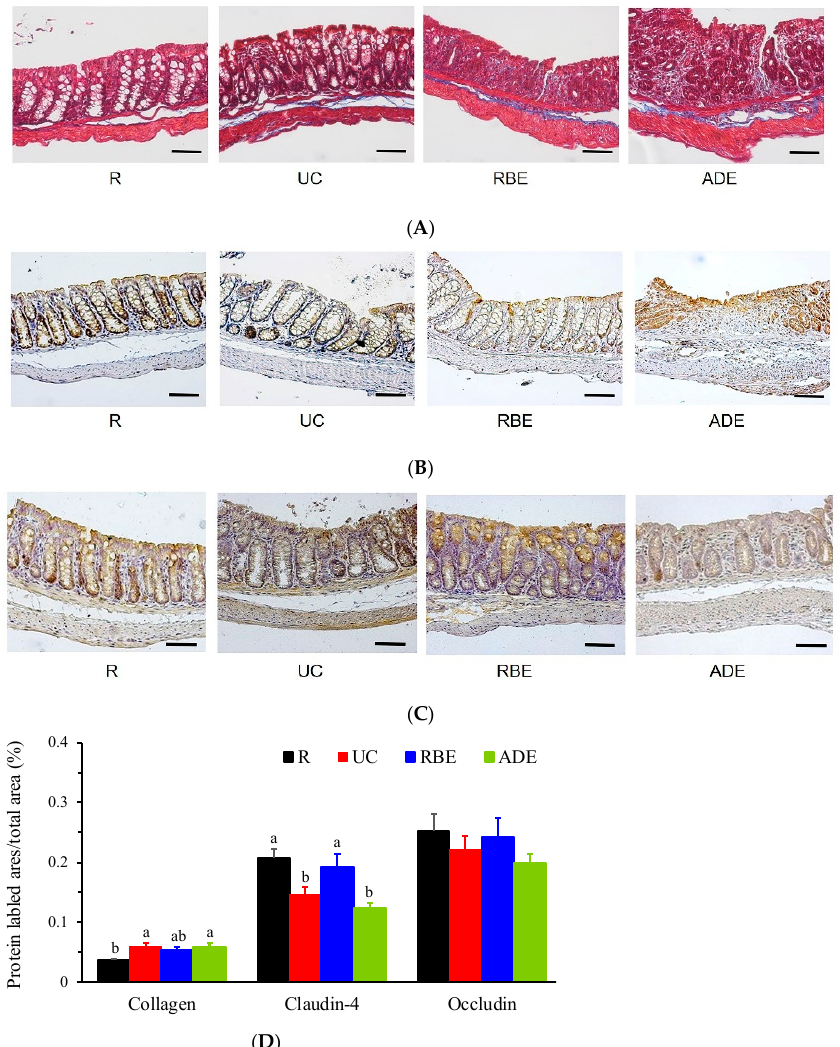
Figure 2. Protein expression of collagen, claudin-4 and occludin in the colon of control mice (R group) fed AIN-93M diet and UC mice fed either the AIN-93M diet (UC group) or the AIN-93M diet supplemented with alcohol extract of rice bran (RBE group) or whole-grain adlay seeds (ADE group). Photos (100×, bars = 50 μ m) of Masson’s trichrome staining for ( A ) collagen, and immunohistochemical staining of ( B ) claudin-4 and ( C ) occludin in the colon and ( D ) the ratio of indicated protein area to total colonic area. Values are mean ± SEM, n = 10-11 per group. Different superscript letters represent significant differences (one-way ANOVA and Duncan's multiple range test, p < 0.05).